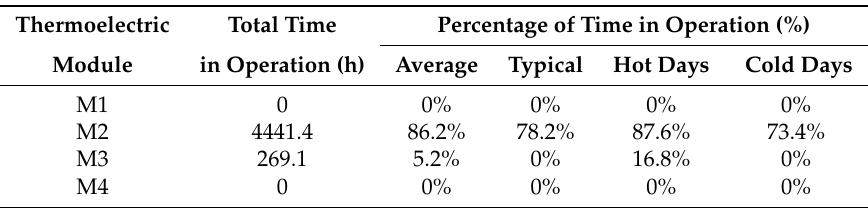
Table 4. Total hours in operation and percentage of time active of the four thermoelectric modules installed, considering the average between 19 December 2019 and 20 August 2020, as well as their